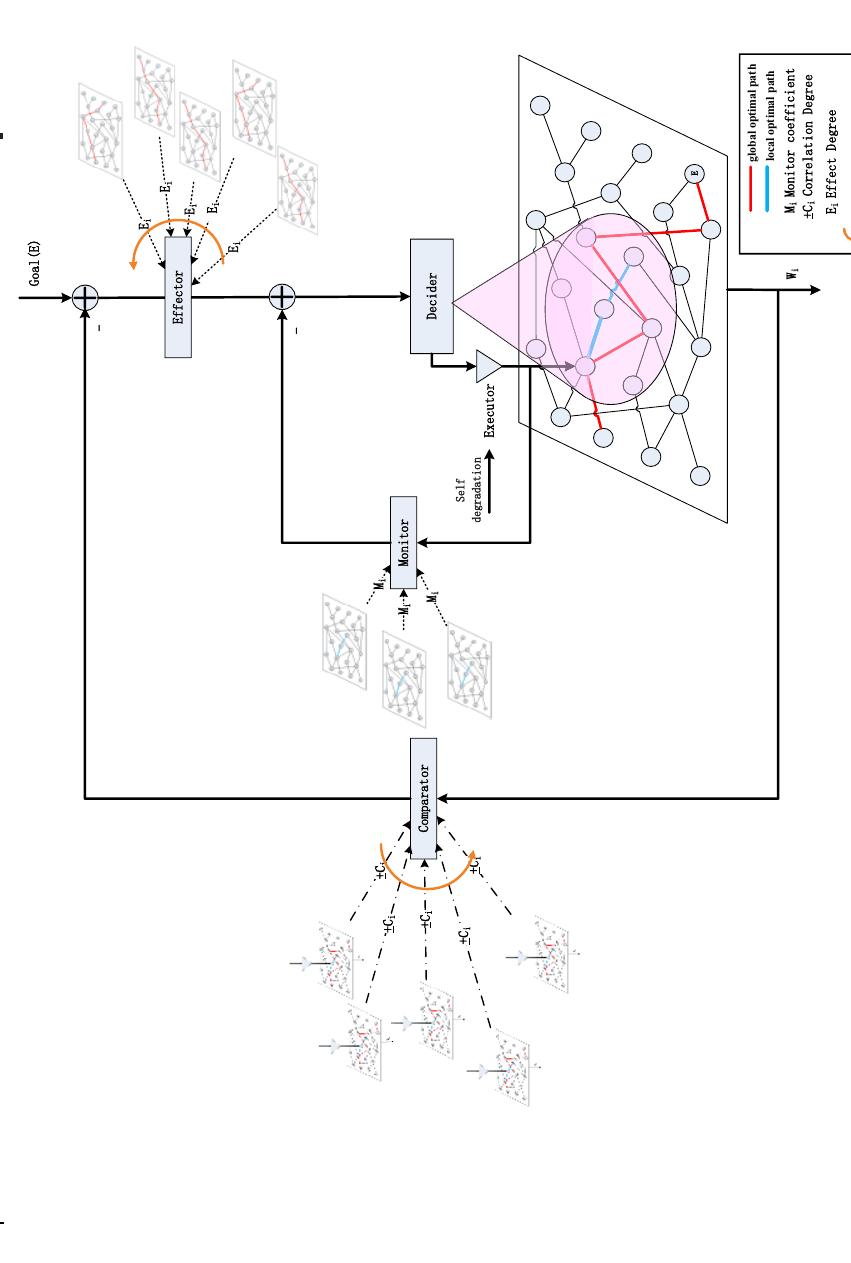
Figure 1. Atomic unit of mind